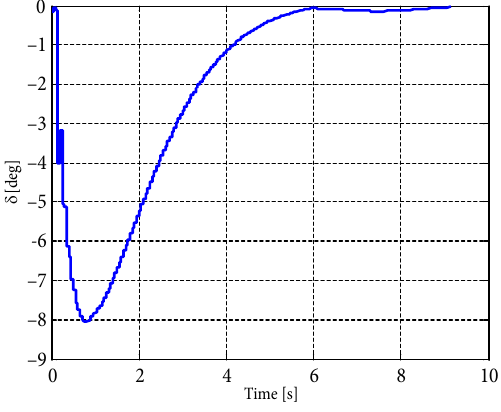
Fig. 12. Steering angle (right-angle turn case)